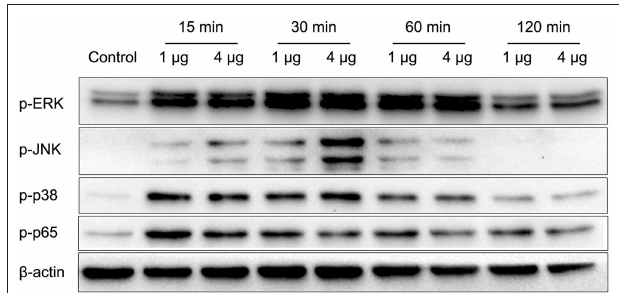
FIGURE 5 | HBHA promotes the phosphorylation of extracellular regulated kinase (ERK), c-Jun N-terminal kinase (JNK), p38, and P65. RAW264.7 cells were stimulated with HBHA (1 and 4 µ g/ml) for 15–120min. Protein extracts were prepared, and the phosphorylation status of ERK1/2, p38, JNK, and p65 was detected via western blotting. Data are representative of at least three independent experiments.